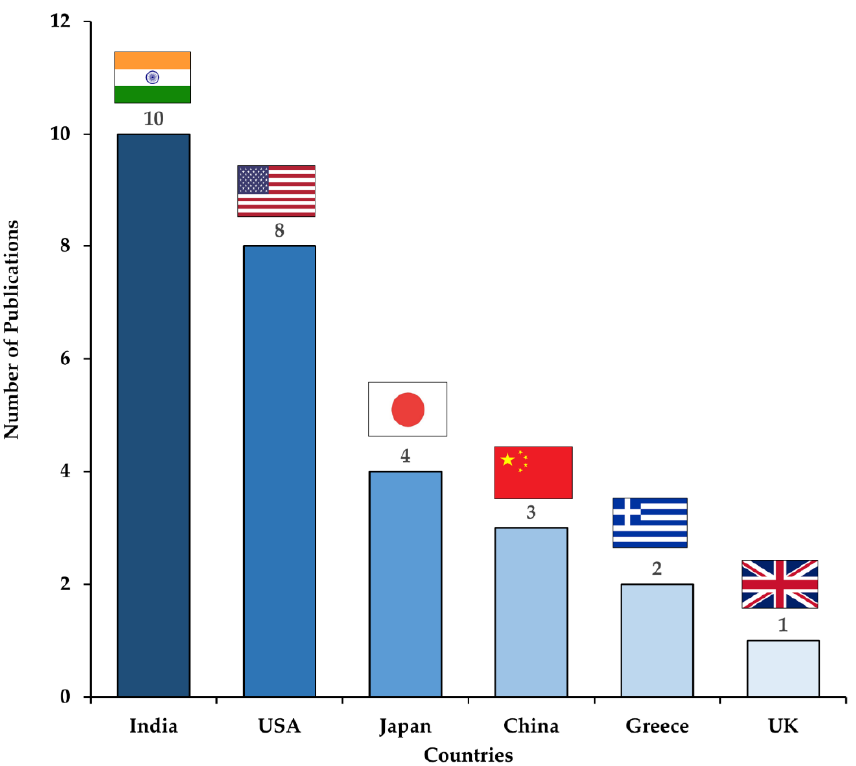
Figure 2. Number of publications of AI models on cytopathological image analysis by country.